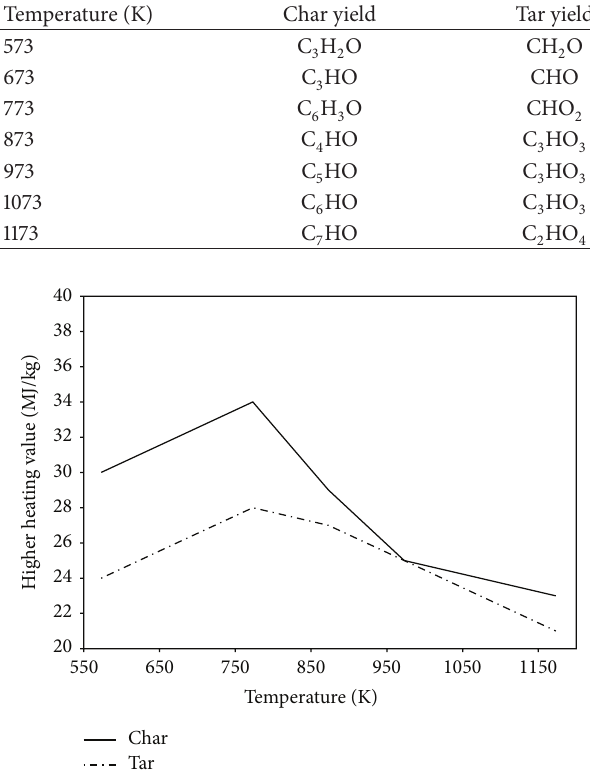
Table 5: Main atomic groups and structure of pyro-oil.